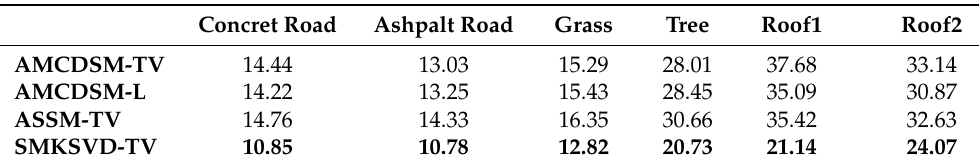
Table 10. HYDICE urban image: Omission errors of each class.